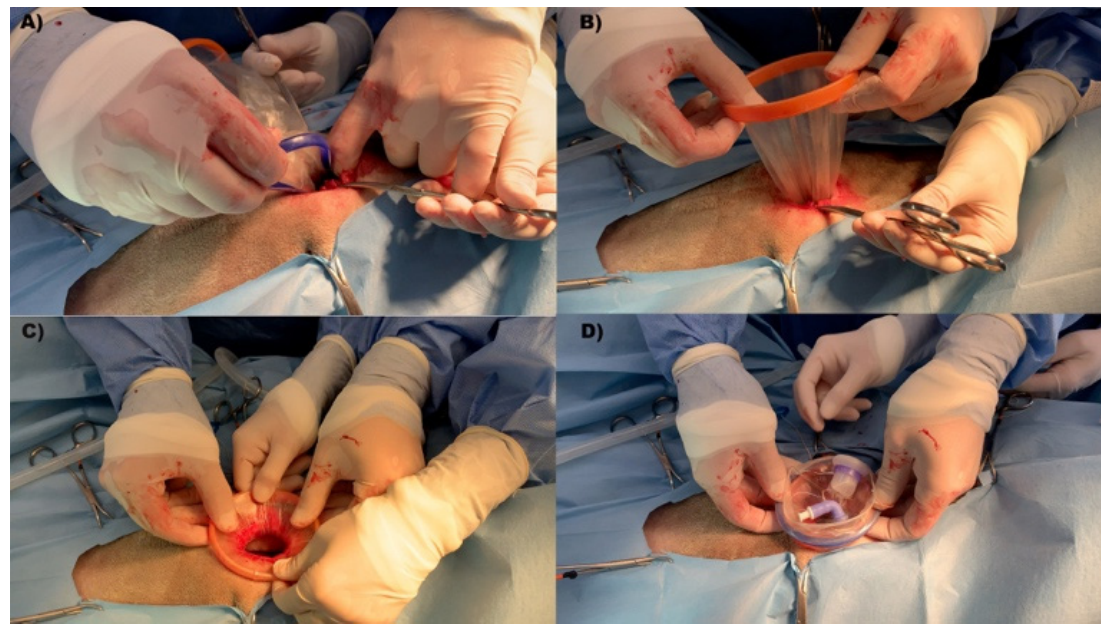
Figure 2. Installation of WRD laparoscopic platform. The WRD was inserted at midline ca. 1 cm caudal to the umbilical scar. Cranial is on the right. ( A ) Inner ring placement through 25 mm mini-laparotomy. The inner ring was squeezed to allow entrance in the abdominal cavity. ( B ) After the proper installation of the inner ring, the outer ring was adjusted for correct wound retraction and stable fixation to the abdominal wall. ( C ) Complete WRD installation and wound retraction. ( D ) The cap was mounted on the outer ring for tight portal sealing, CO 2 gas tube connection, and instrument introduction.